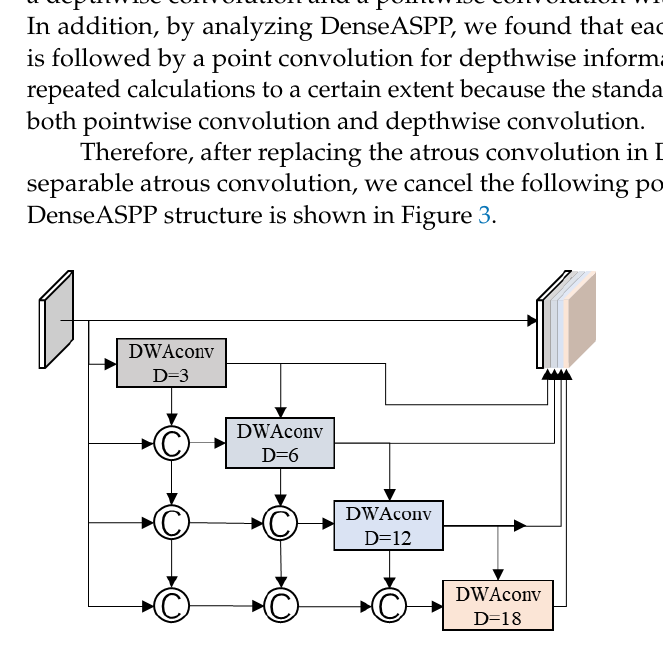
Figure 3. Details of